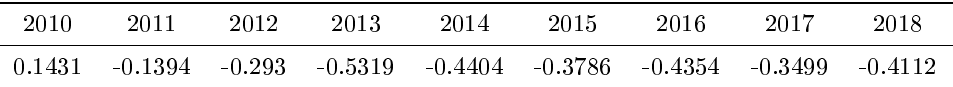
Table 3: Correlation between government expenditure in the region and LGU tax revenues, per